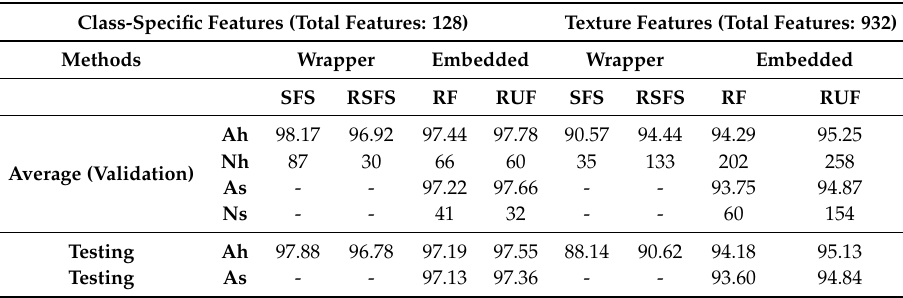
Table 4. Wrapper and embedded methods: Experimental protocol 1. Class-Specific Features (Total Features: